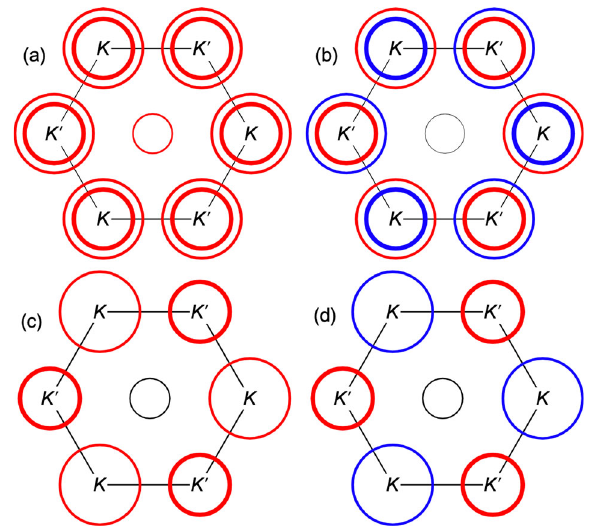
Fig. 3 Schematic illustration of the Ising superconductor pairing symmetry. Schematic illustration of possible pairing symmetry in a regular superconductor with hybridization-split, Kramers- degenerate Fermi surfaces (with inversion symmetry), and in an Ising superconductor. Splitting and superconductivity on the Γ pocket are neglected. The color shows the sign of the order parameter. a , c correspond to an s-wave, and b , d to a f-wave symmetry. Note that in the IS the order parameter cannot be independently de fi ned for k and − k , so only one is